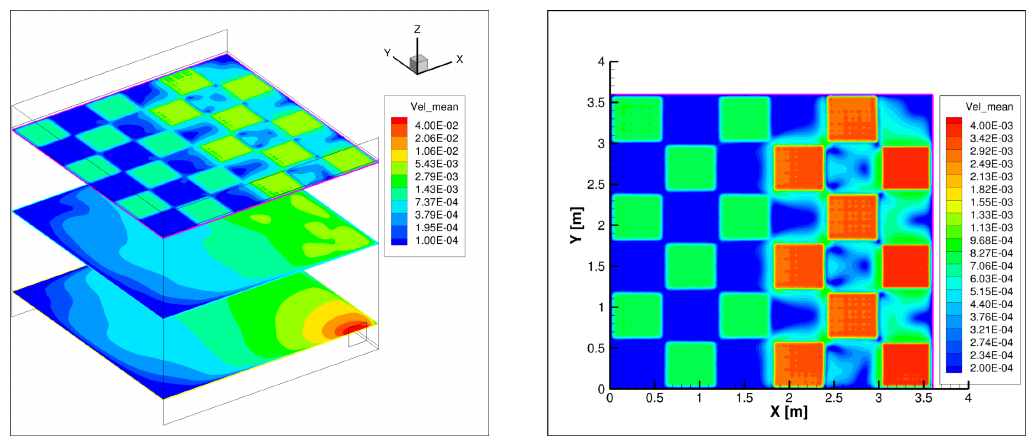
Figure 8. Velocity contour: three horizontal planes (left); the top plane below the ceiling (right) for the chessboard distribution in configuration Outlet 1.